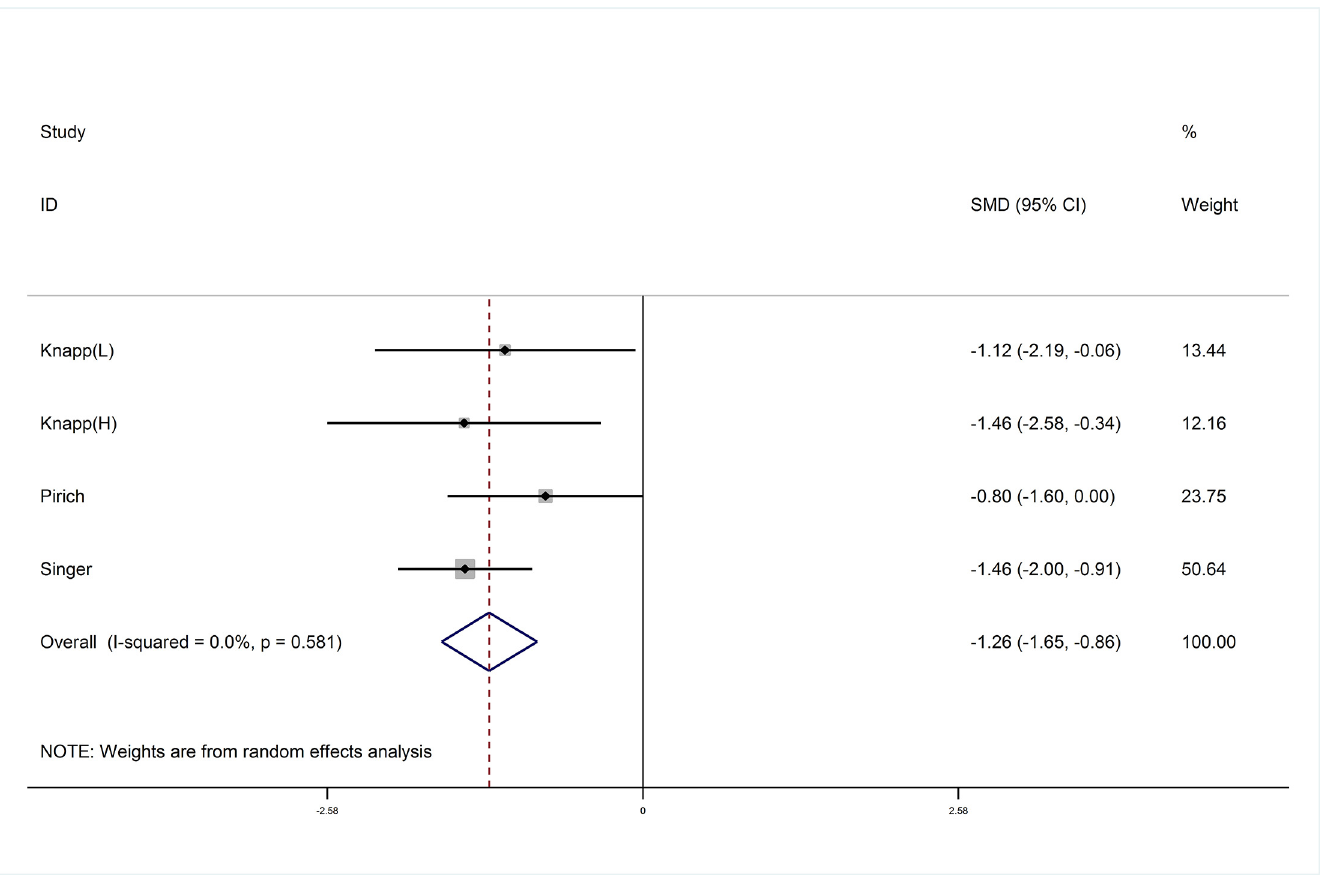
Fig 4. Pooled effect size of marine-derived PUFA supplementation on TXB 2 .in subjects with high risk of CVD. CVD, cardiovascular disease. SMD, standard mean